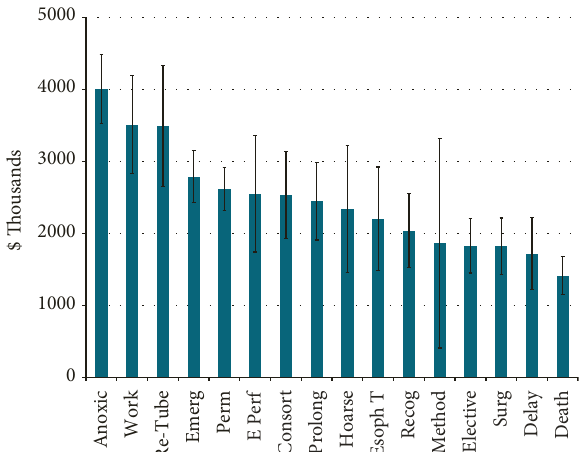
Figure 6: Mean payments of cases containing the most common factors cited in litigation. Abbreviations same as those in the previous figure.